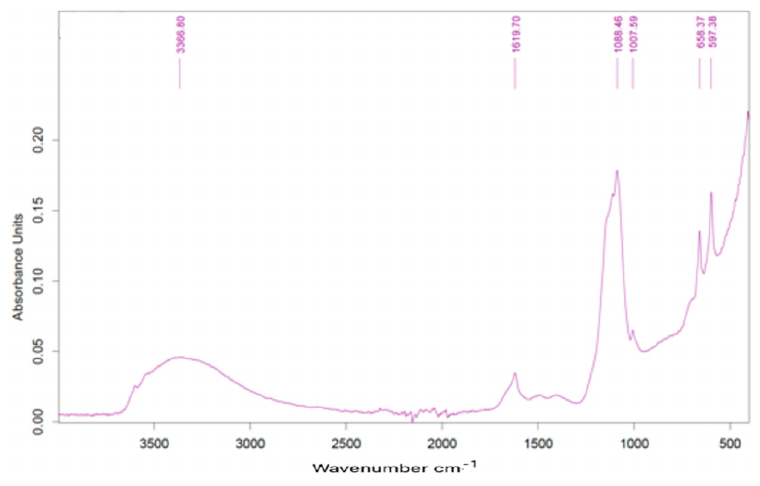
Figure 10. FTIR spectrum of dried sample.